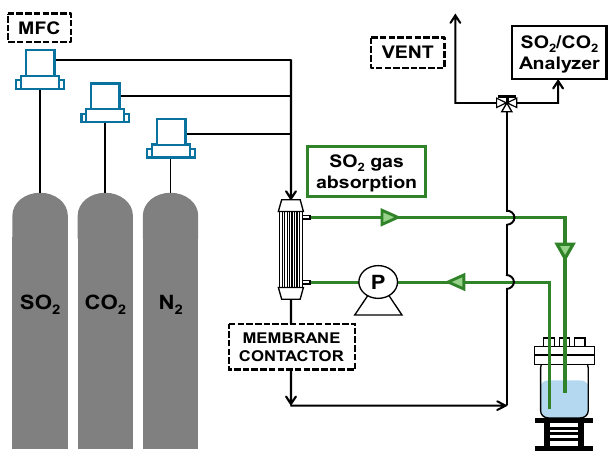
Figure 1. A schematic diagram of the experimental apparatus (MFC, mass flow controller).